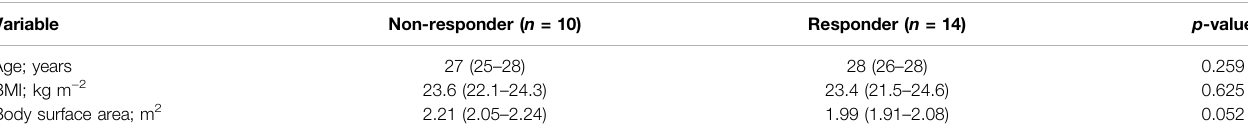
TABLE 1 | Demographics data. Responders were de fi ned by an increase in stroke volume of 10% after a fl uid challenge of 500 ml. BMI: body mass index.